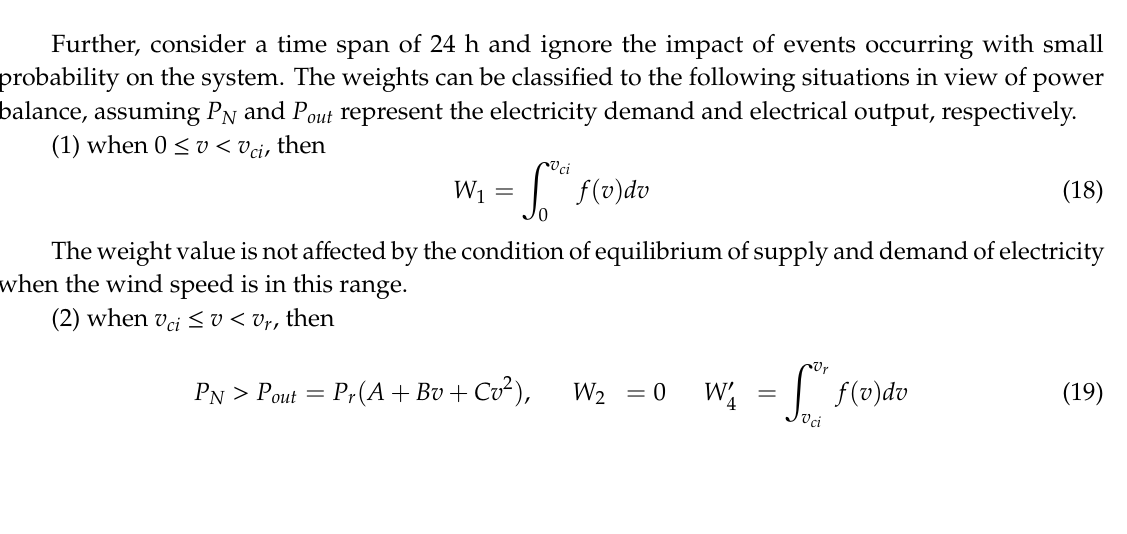
Figure 4. Relationship between wind speed and wind power.